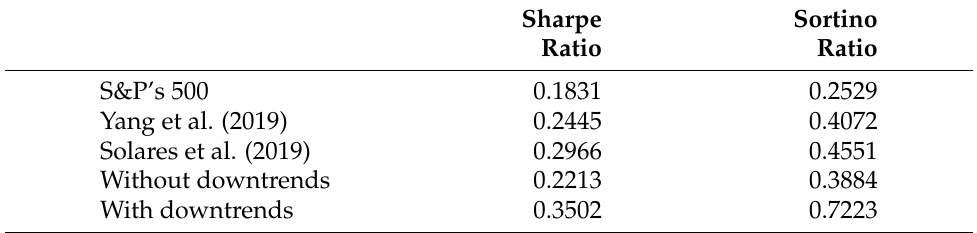
Table 3. Comparison of benchmarks with the proposal by using the Sharpe and Sortino